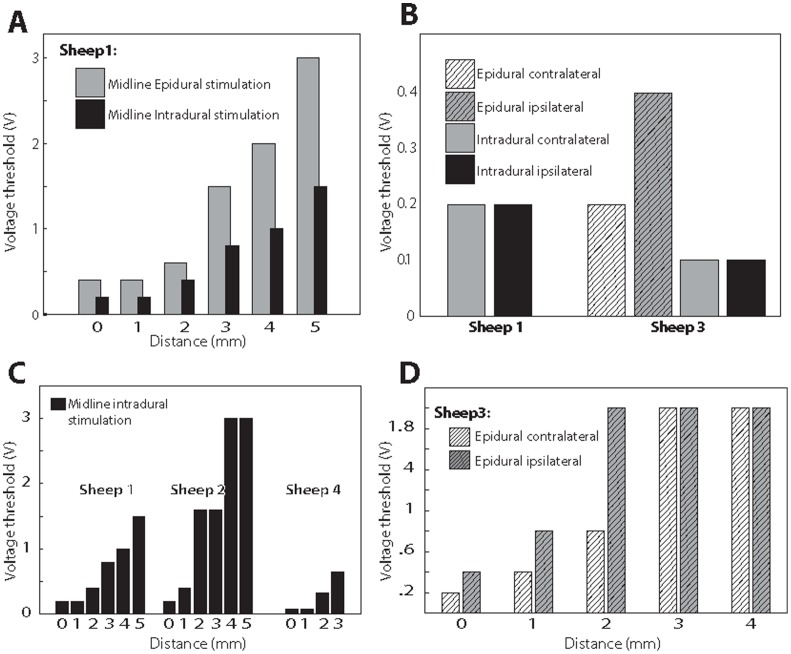
Summary of voltage thresholds needed to evoke high gamma band response (VT).(A) comparison between midline epidural stimulation and intradural stimulation. Y-axis represents VT. X-axis denotes the distance of the neurostimulator from the dorsal surface of the spinal cord. (B) Comparison between Contralateral and ipsilateral spinal cord stimulation for intra- and epidural stimulation. (C) summary of VT (y-axis) using spinal electrical stimulation of the midline in three sheep. X-axis represents the distance of the neurstimulator from the midline. (D) Comparing VT between ipsilateral and contralateral dorsal column electrical stimulation at multiple distances (X-axis).